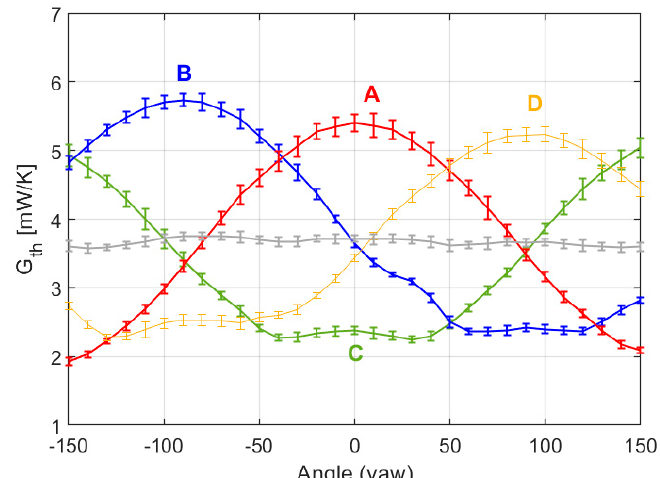
Figure 23. Experimental results showing the evolution with the yaw angle of the average convective heat transfer coe ffi cient G th of each sector of the sphere (inferred from the average power delivered to each sector) at Re = 1000. The grey line is the average G th of the sectors. The 1 σ error bars of the measurements are also shown. The disposition of the sectors A, B, C and D is the same the one shown